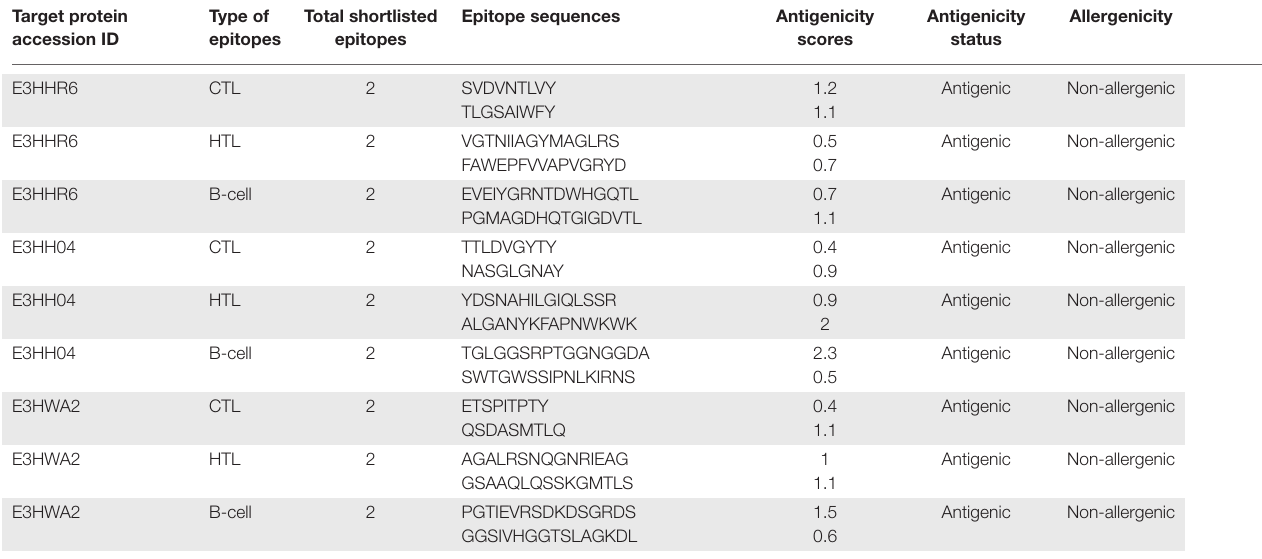
TABLE 2 | The shortlisted immune epitopes with antigenicity and allergenicity status evaluated for each target protein.